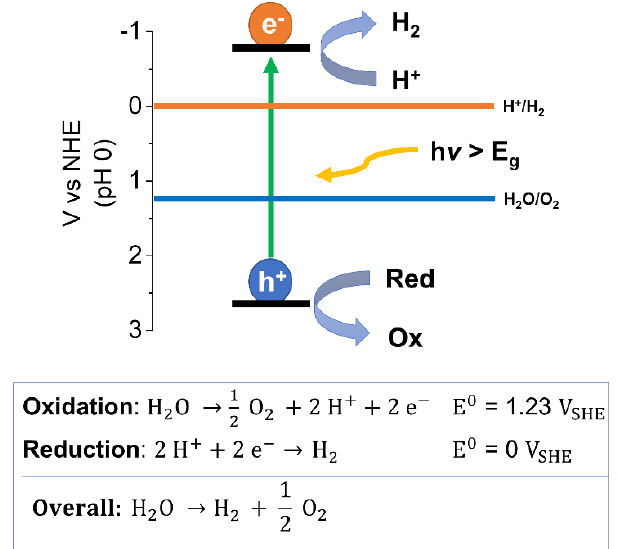
Figure 3. Mechanism and redox reaction involved in photocatalytic water splitting.